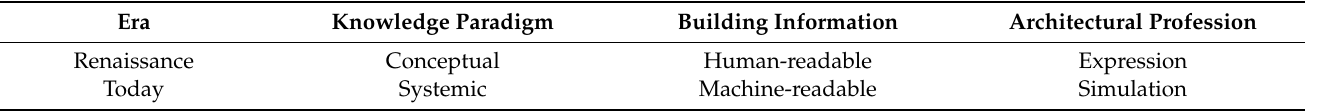
Table 1. The essence of the architectural profession by era.